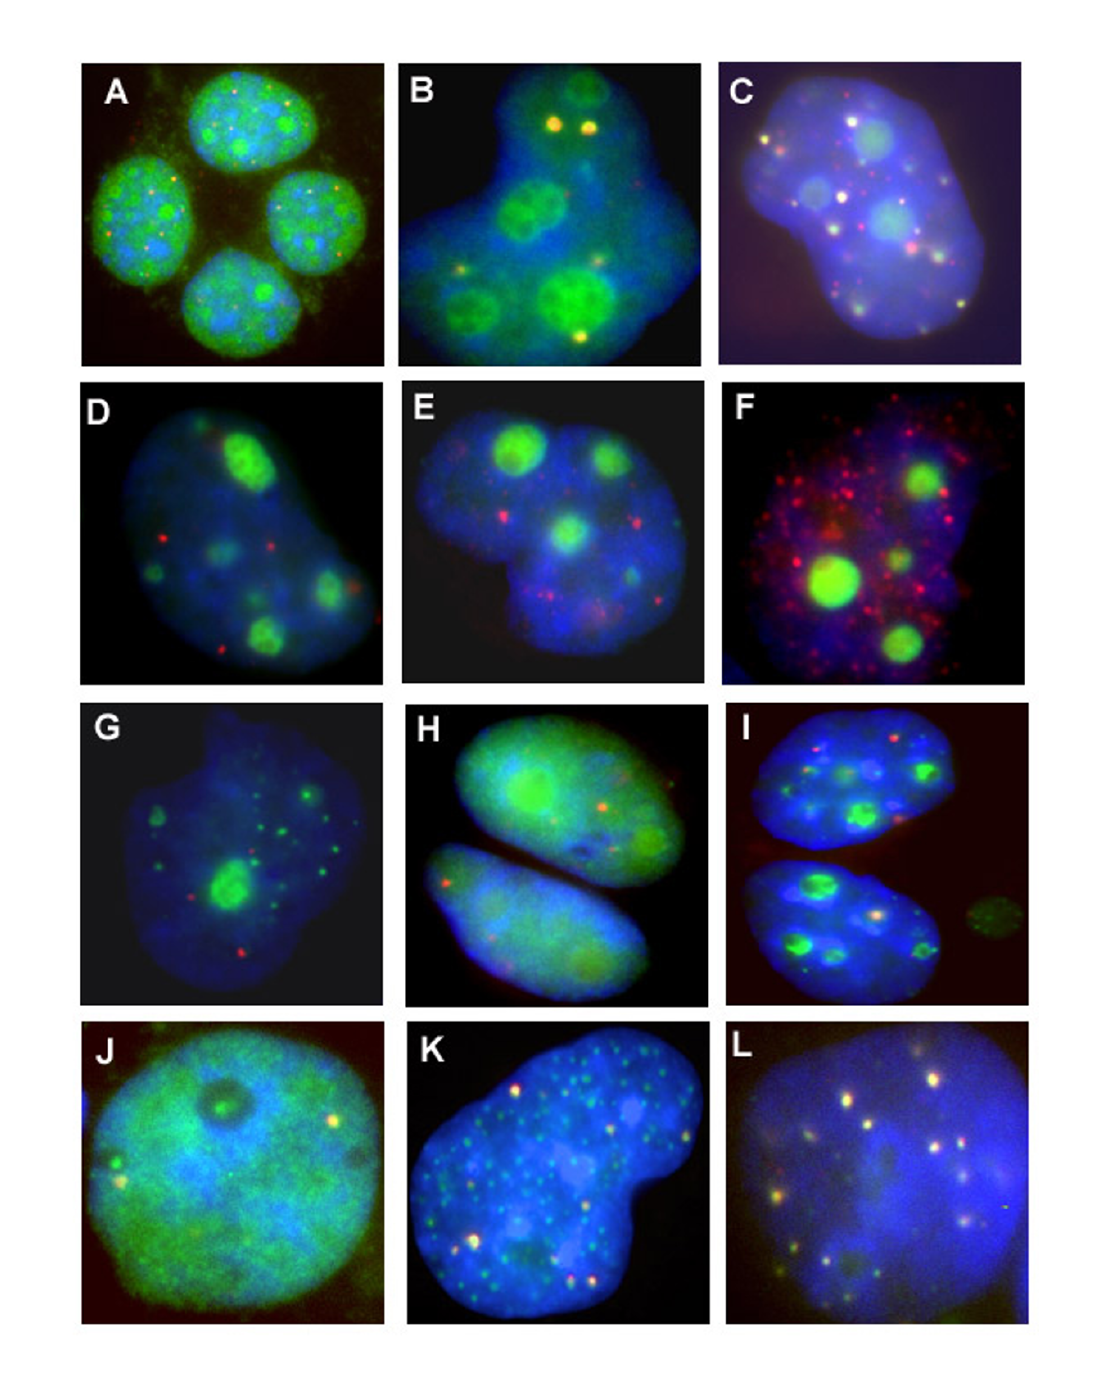
Figure 4 Localization of GFP-BLM fusion proteins. The immunofluorescent images show representative cells from each trans- fected cell line. Localization of GFP or GFP-BLM fusion proteins and PML ( α -PML and Donkey α -mouse Texas Red secondary) or TOPIII α ( α -TOPIII α and Donkey α -rabbit Texas Red secondary) in DAPI-stained nuclei are shown. A. EGFP + α -PML. B. GFP-BLM + α -PML. C. GFP-BLM + α -TOPIII. D. GFP- ∆ N1 + α -PML. E. GFP- ∆ N2 + α -PML. F. GFP- ∆ N2 + α -TOPIII. G. GFP- ∆ N3 + α -PML. H. GFP- ∆ N4 + α -PML. L GFP-K695T + α -PML. J.GFP- ∆ H1 + α -PML K. GFP- ∆ C1 + α -PML. L. GFP- ∆ C2 + α - TOPIII. The parental SV40-transformed BS cell line lacks detectable BLM